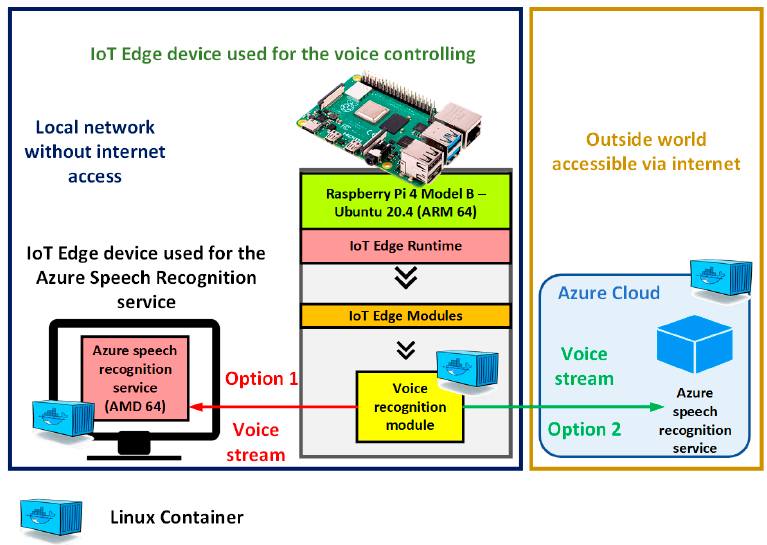
Figure 12. Possible location for running the Azure Speech Recognition service.